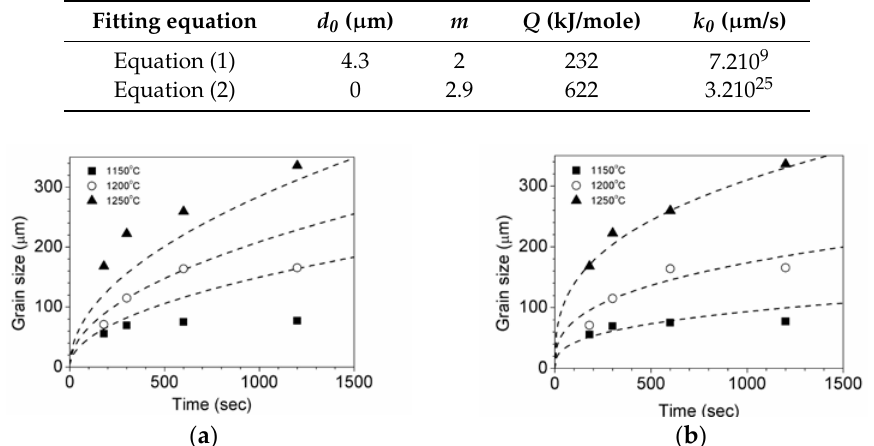
Table 2. Parameters of the fitting equations of Equations (1) and (2) for SS400 with 1.5 ppm Mg.